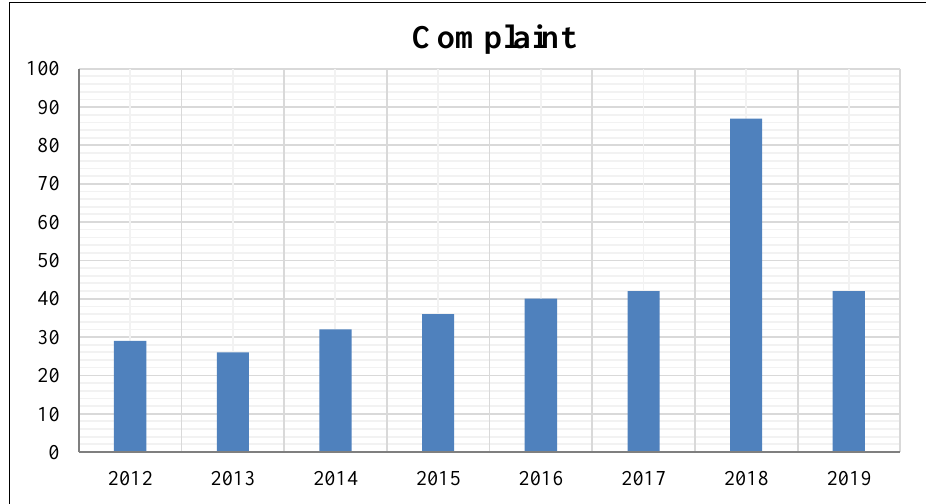
Figure 6. Graphic submission of complaints over the years by